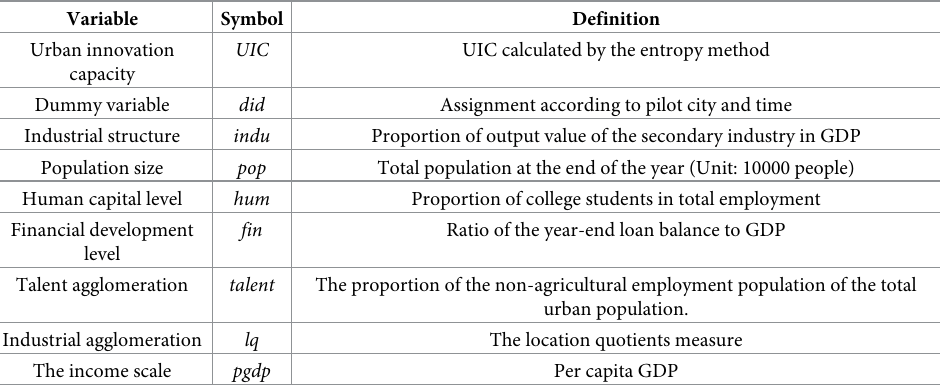
Table 2. Definitions of the variables.